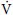
Relationship between the decline in aerobic capacity and the increase in dead space.The mean annual changes in peak V˙
o
2 (ΔpV˙
o
2) were significantly correlated with those in the dead space fractions (ΔV˙
d/V˙
t) (p<0.0001, r = -0.603).